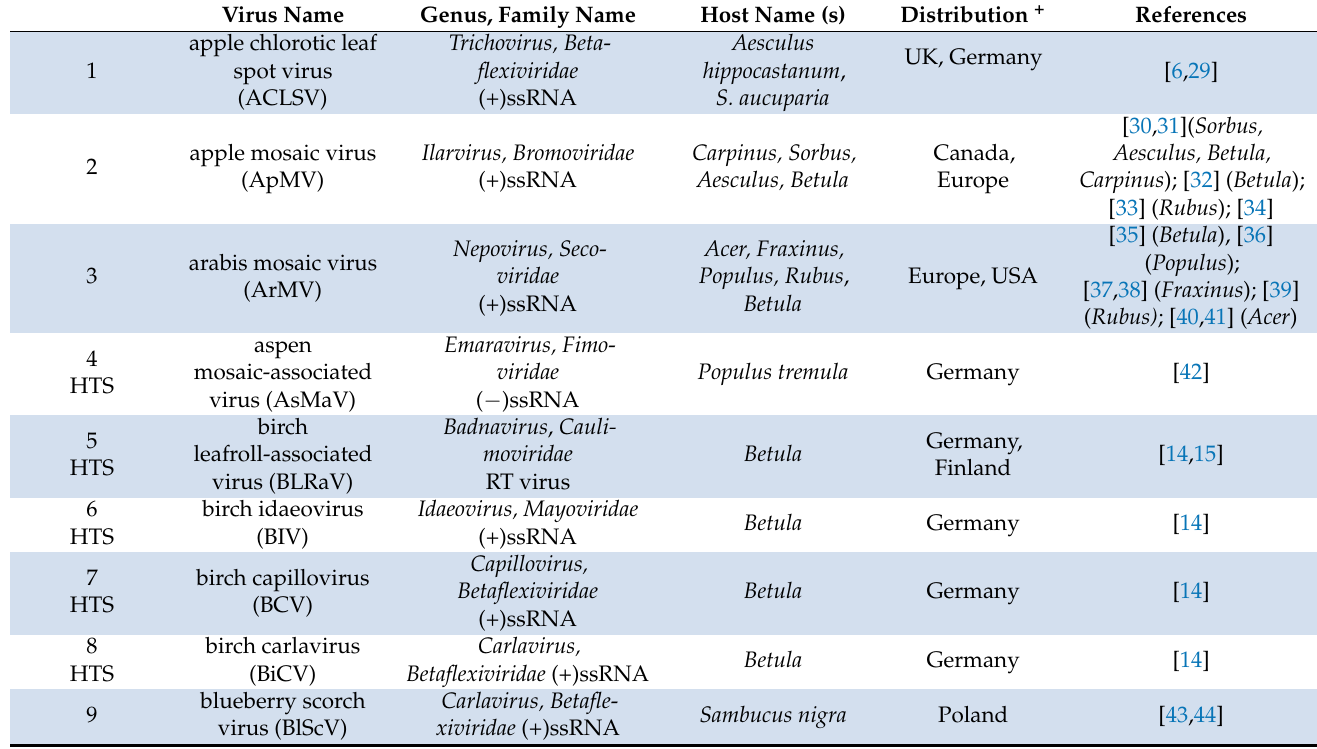
Table 1. Plant viruses infecting tree/shrub hosts and cryptoviruses. For each virus, the virus name, genus and family name, virus tree/shrub host(s), countries in which the virus was reported and the related references are given. Numbers in the first column represent ordinal numbers of the listed viruses. Viruses that were discovered by means of HTS methods are indicated by the note “HTS” next to their ordinal